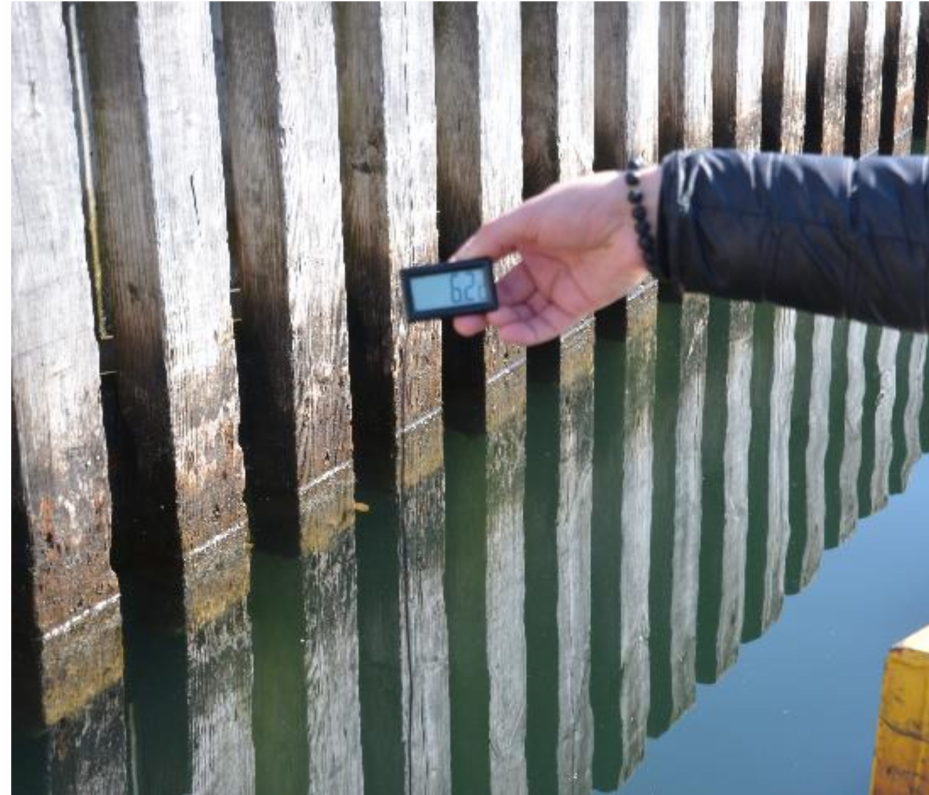
Figure 2. Measurement of the water